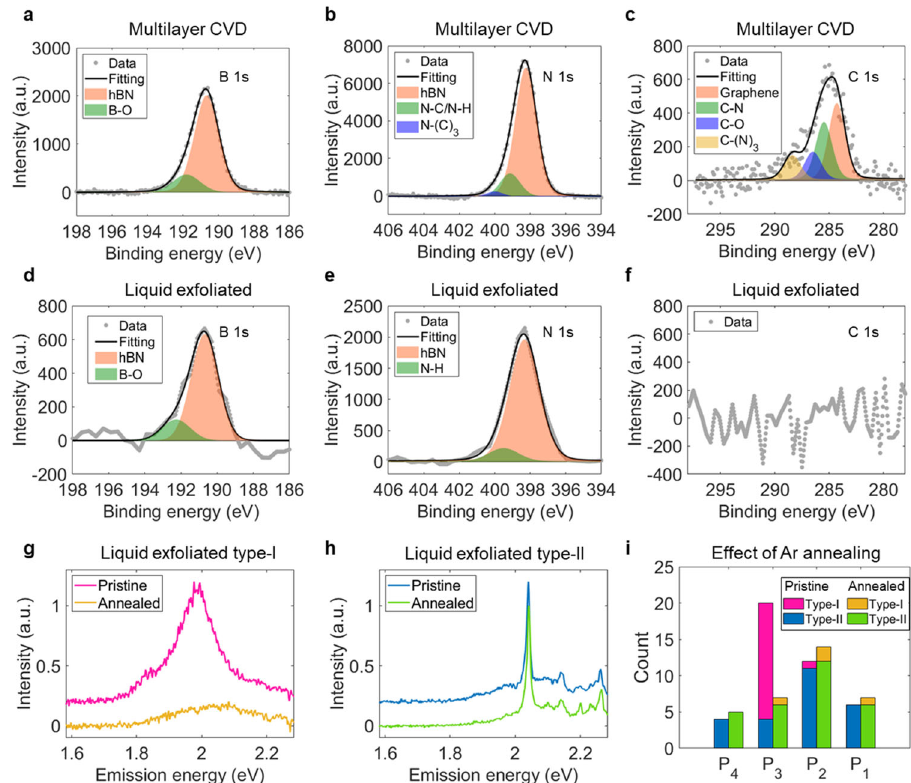
Fig. 6 XPS characterization of different hBN samples and annealing effect on liquid exfoliated hBN. XPS spectra of hBN samples that are pre-cleaned with Ar ion sputtering, showing B 1 s ( a , d ), N 1 s ( b , e ), and C 1 s ( c , f ). While ( a ) to ( c ) represent multilayer CVD hBN, ( d ) to ( f ) are results of multilayer liquid exfoliated hBN. The C concentration is higher in the CVD sample, mainly in the form of sp 2 C-C, which corresponds to graphene domains. Note that C-N is different from C-(N) 3 , with details in Supplementary Fig. 18 and Supplementary Table 3. g Photoluminescence (PL) spectra of type-I emission in liquid exfoliated hBN, before (pink) and after (yellow) annealing at 850 ˚ C in Ar for 30 min. h PL spectra of type-II emission in liquid exfoliated hBN, with sharper zero-phonon lines (ZPLs), before and after annealing at 850 ˚ C in Ar for 30 min. i Number of each emitter species P i ( i = 1, 2, 3, 4) in liquid exfoliated hBN, before (left bars) and after (right bars) 850 ˚ C annealing in Ar. Pink and yellow colors indicate broad ZPLs, corresponding to type-I emission. Blue and green indicate sharp ZPLs, corresponding to type-II emission. Before annealing, P 3 has a large percentage of type-I emitters, which disappear almost completely after annealing. All type-II emitters remain the same after annealing, regardless of the emission species P i ( i = 1, 2, 3, 4). More details of thermal annealing experiments are presented in Supplementary Note